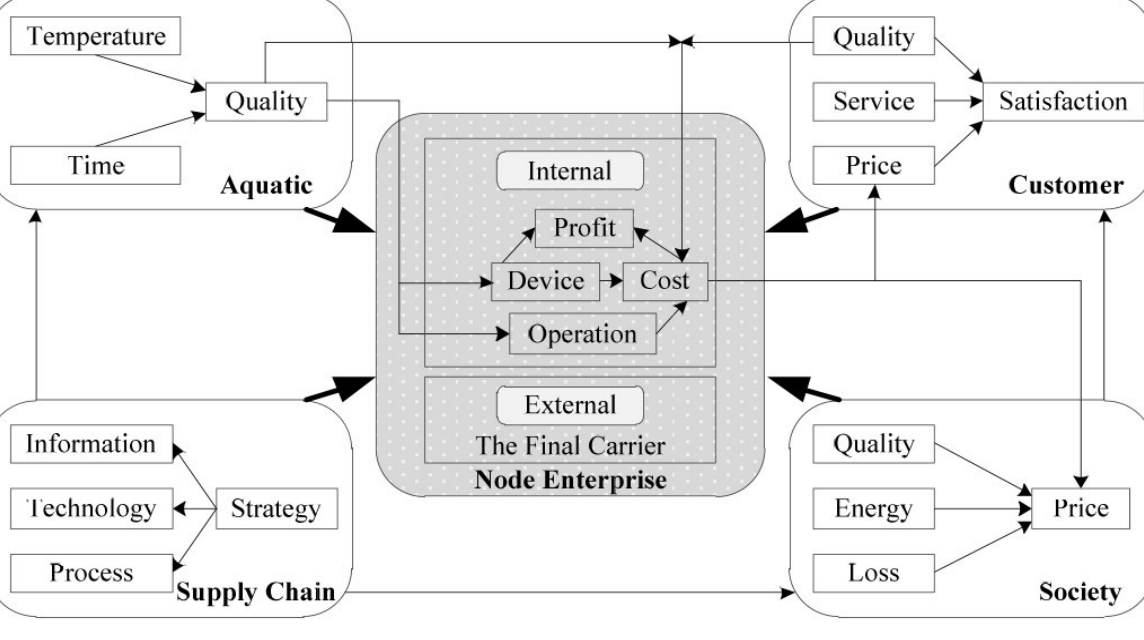
Figure 2. The ACSSN